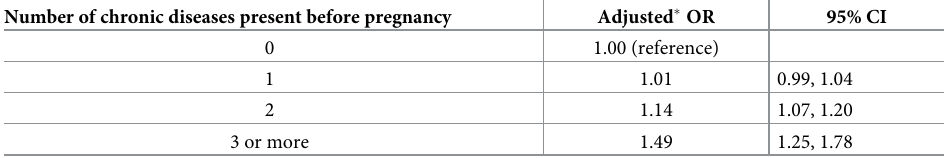
Table 2. The adjusted � odds ratios (OR) of miscarriage according to number of preexisting chronic conditions registered prior to pregnancy in 593,009 pregnancies. Number of chronic diseases present before